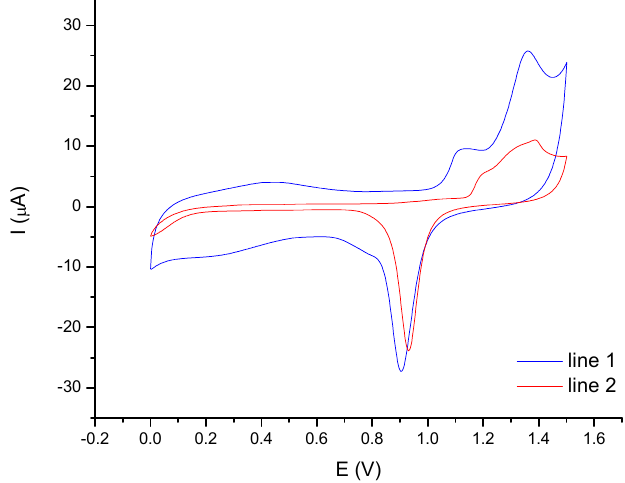
Figure 2. Cyclic voltammetry (CV)-voltammograms recorded in 0.5 M H 2 SO 4 for gold nanoparticles modified glassy carbon electrode (AuNPs-GCE), line 1, and solid gold electrode (SGE), line 2.